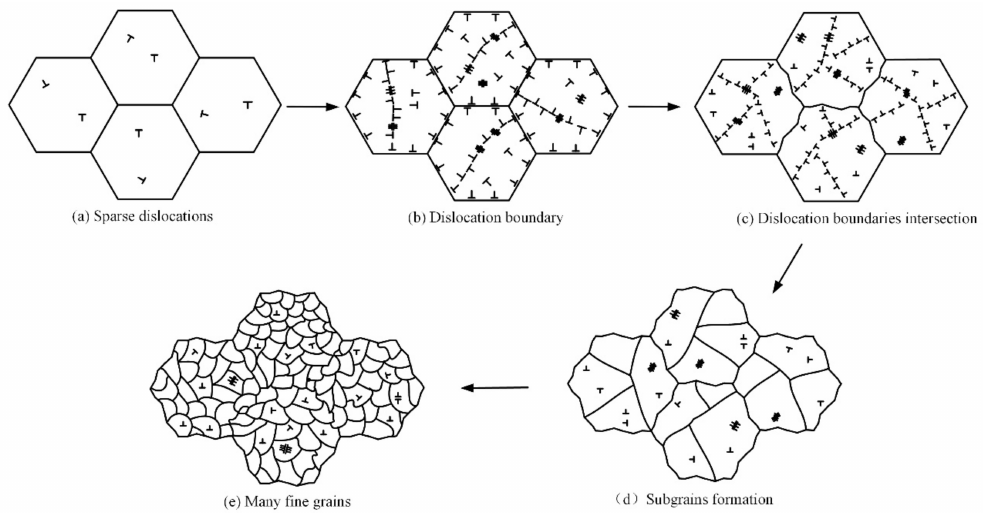
Figure 14. Grain refinement model dominated by the dislocation movement of the E690 high-strength steel cladding layer fabricated by